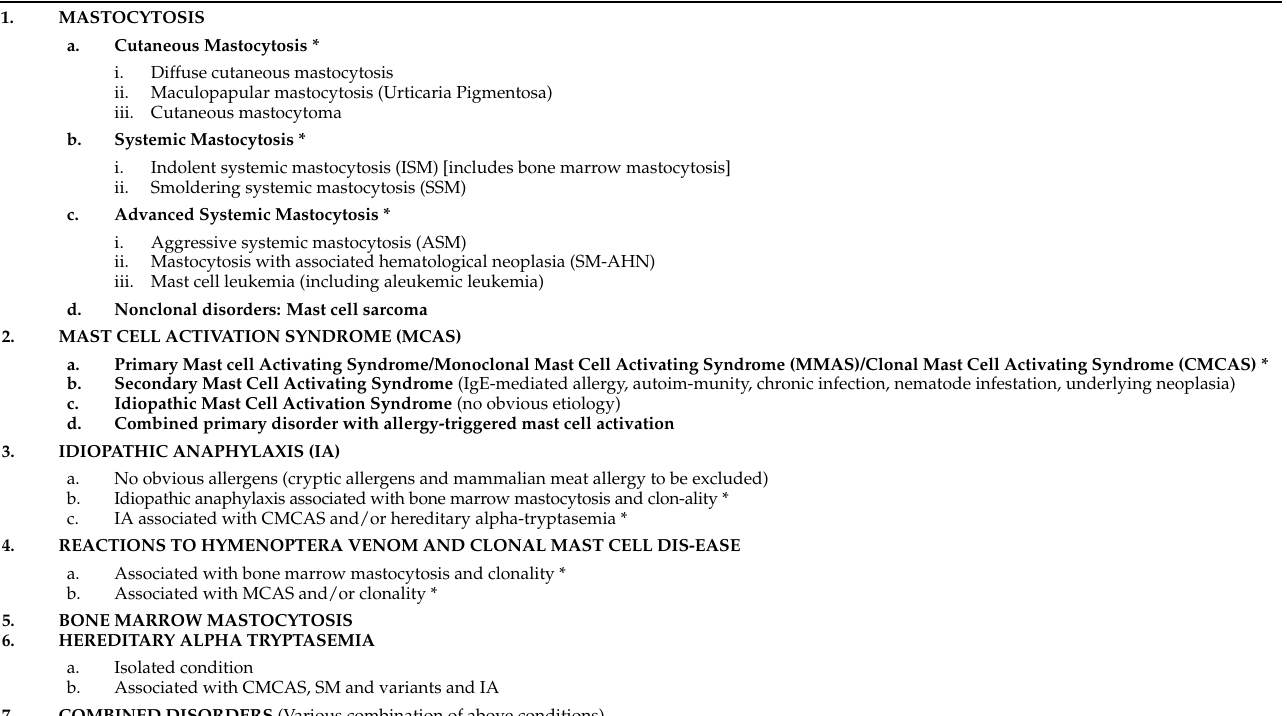
Table 1. Classification of Disorders Associated with Mast